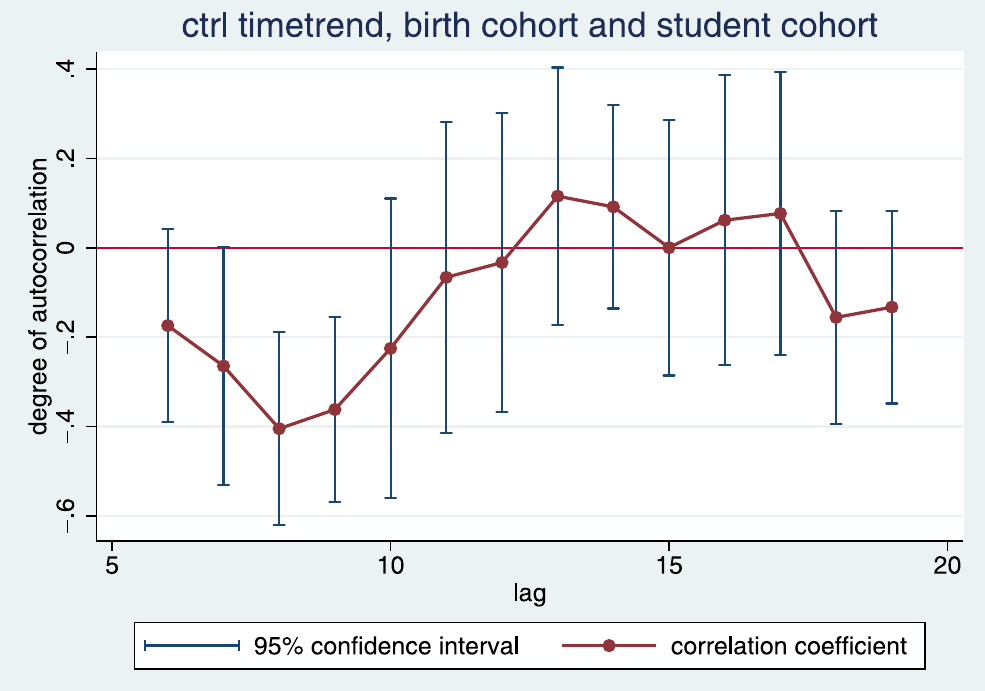
Fig 7. Adding Time Trend, Birth Cohort and Student Cohort. Dots are the coefficients of the lag of the number of habilitations x years ago, bars represent the standard error of this regressor.